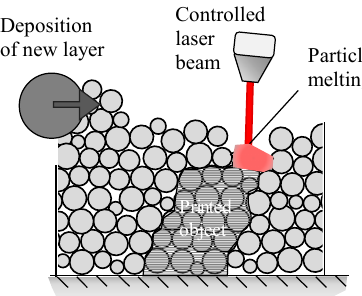
Figure 1. Selective laser melting additive manufacturing process illustration.